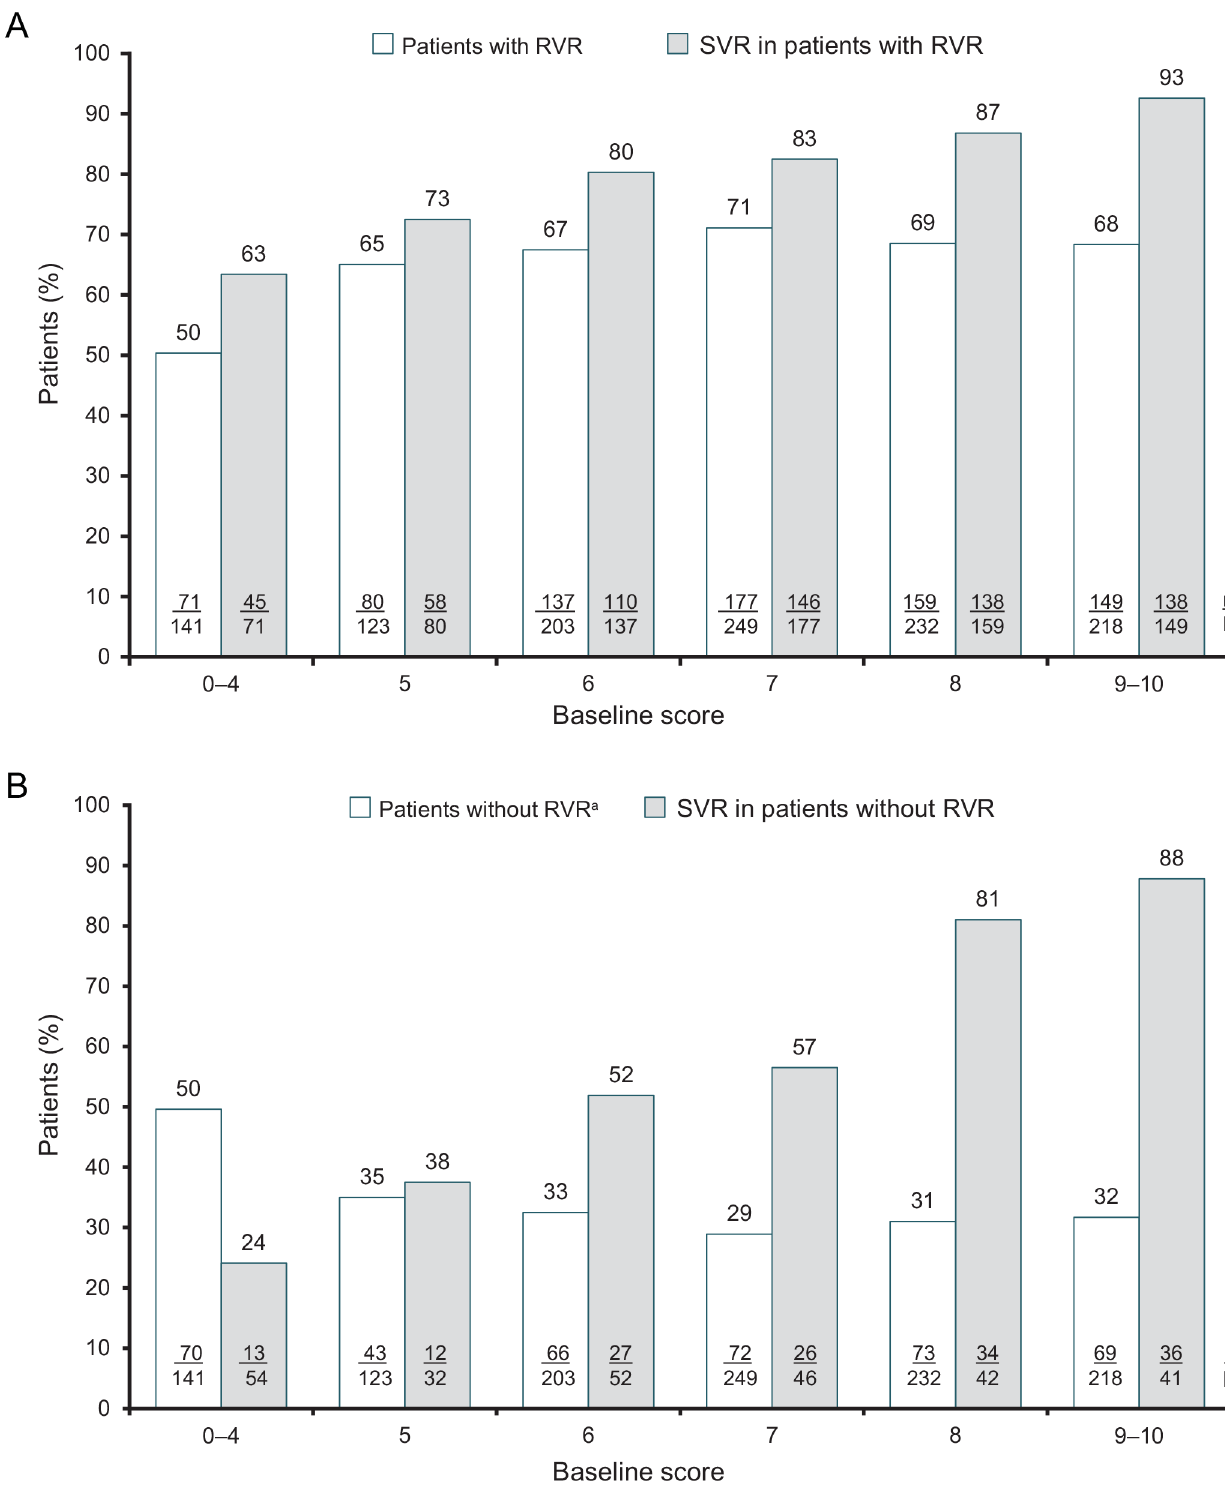
Fig 11. Rapid virologic response (RVR) and sustained virologic response by RVR status in patients with HCV genotype 3 by baseline score. A) Patients with an RVR; B) Patients without an RVR. RVR = rapid virologic response: HCV RNA < 50 IU/mL by week 4 of treatment. a Includes patients with missing Week 4 HCV RNA